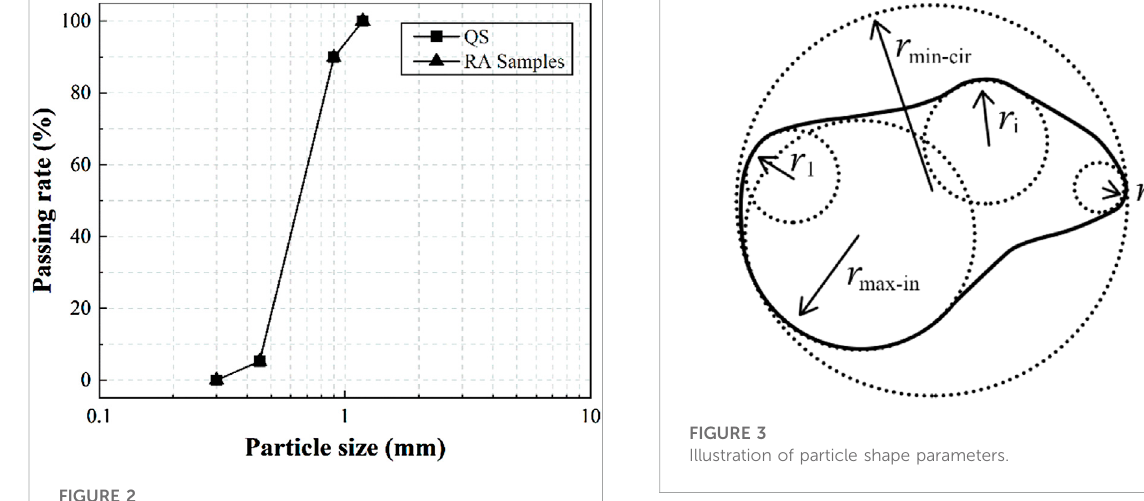
FIGURE 2 The grading of QS and RA samples.